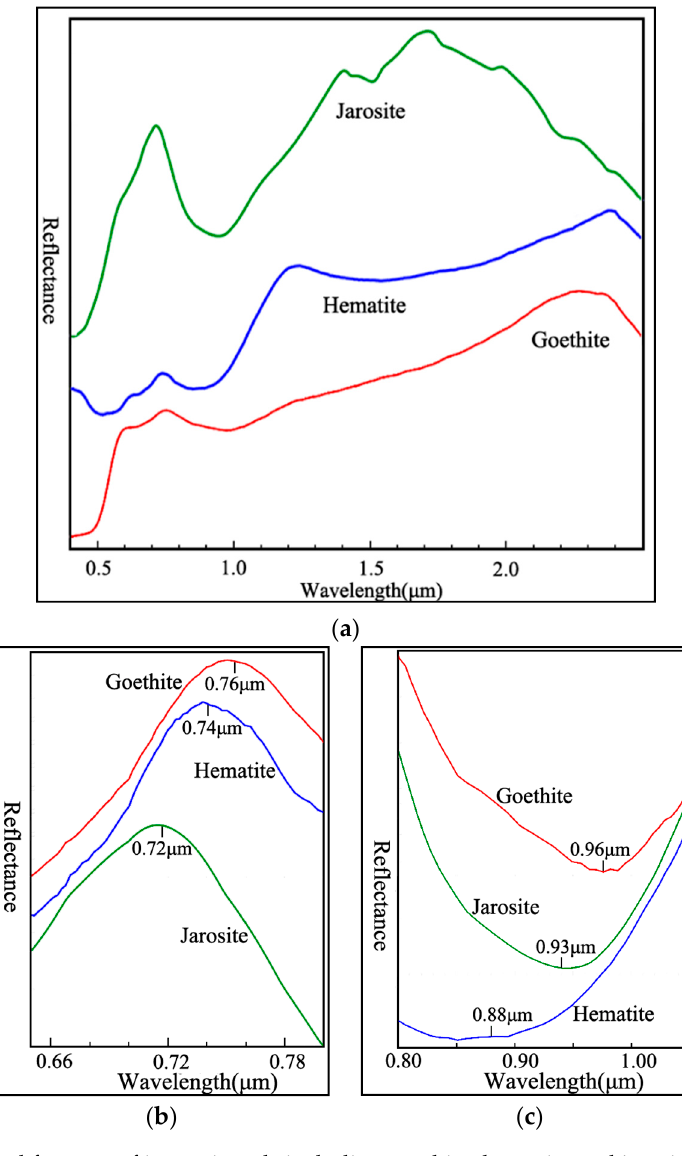
Figure 2. Spectral features of iron minerals including goethite, hematite and jarosite obtained from the United States Geological Survey (USGS) spectral library [43,44]. ( a ) reflectance spectra of goethite, hematite and jarosite; ( b ) reflectance features of iron minerals near 0.7 µm; ( c ) absorption features of iron minerals near 0.9 µm.